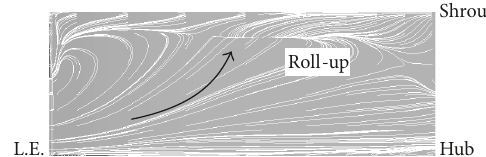
Figure 12: Limiting streamlines on diffuser suction surface.